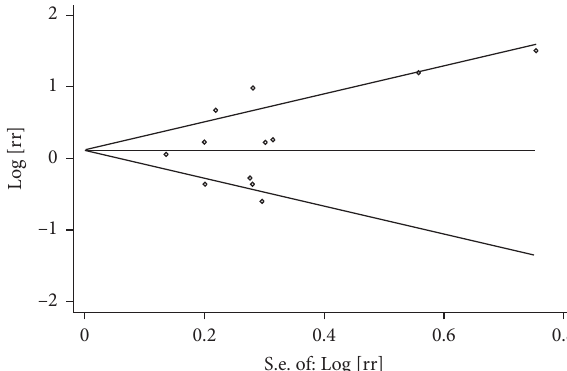
Figure 2: The funnel plot in Egger’s test and Begg’s test. Filled funnel plot with pseudo 95% confidence limits